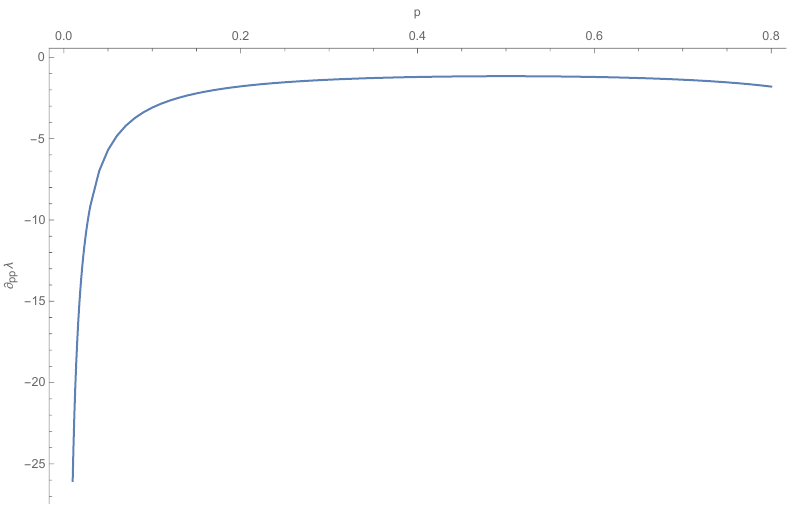
Figure 5 . The derivative ∂ pp λ ( M, p ) evaluated on the critical line, shown as a function of p . We see no zeros or singularities for 0 < p < 1